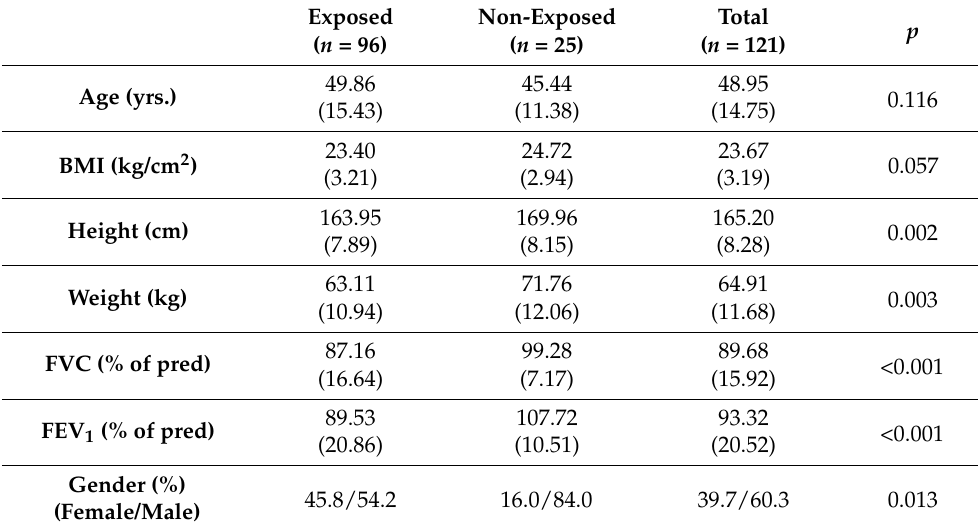
Table 1. Demographic data and PFT measurements for HD-exposed and unexposed subjects. Entries are mean (SD) unless otherwise specified. The differences between the means of independent groups were analyzed by Welch’s t -test and the significance level was set as 0.05. Chi-square test was used to examine the relationship between two categorical